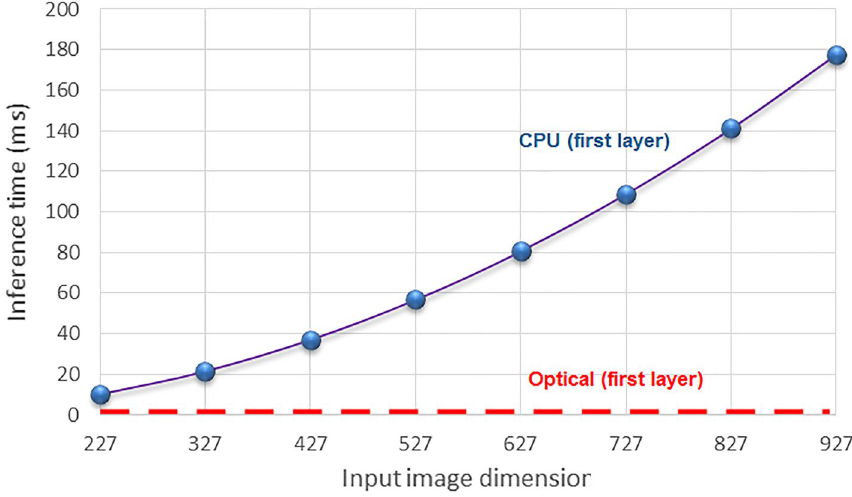
Figure 14. Inference time of the optical and electrical implementations of the first layer of AlexNet in terms of input image